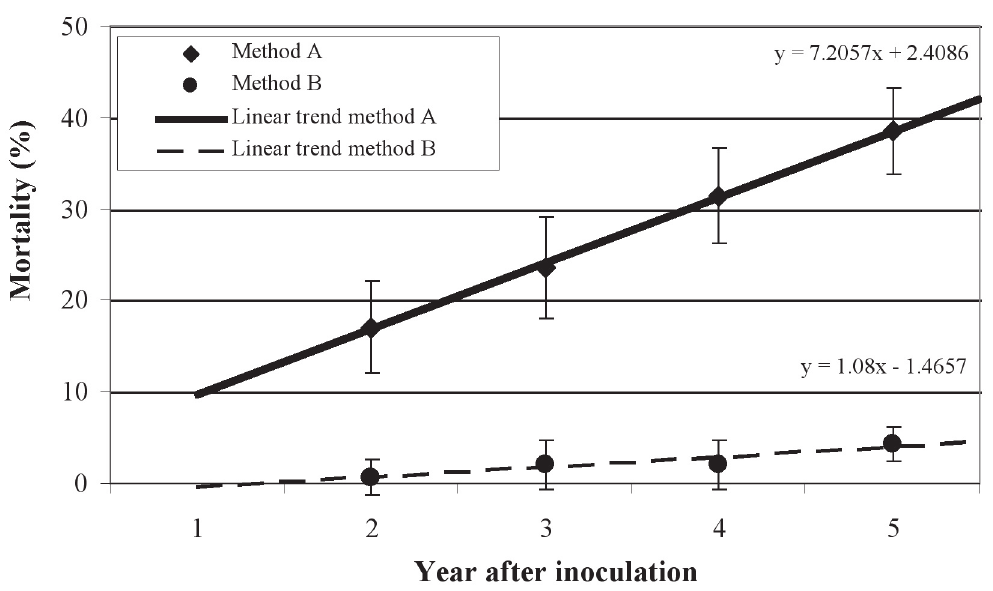
Fig. 1. Cumulative mortality (%) due to Armillaria mellea infection of grapevine rootstocks planted in A. mellea -infected substrate (Method A) or inoculated by inserting rhizomorphs under the root bark (Method B), in the course of a five- year study. Vertical bars represent standard errors. Each value represents the mean of two experiments.